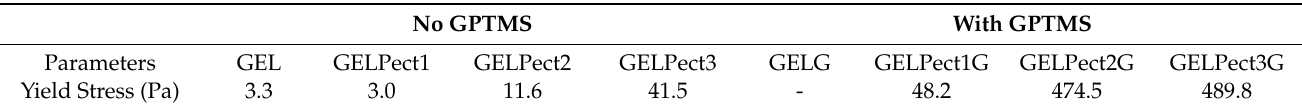
Table 3. Yield stress values of GELPect slurries and GELPectG biomaterial inks. (The yield stress of GELG was not